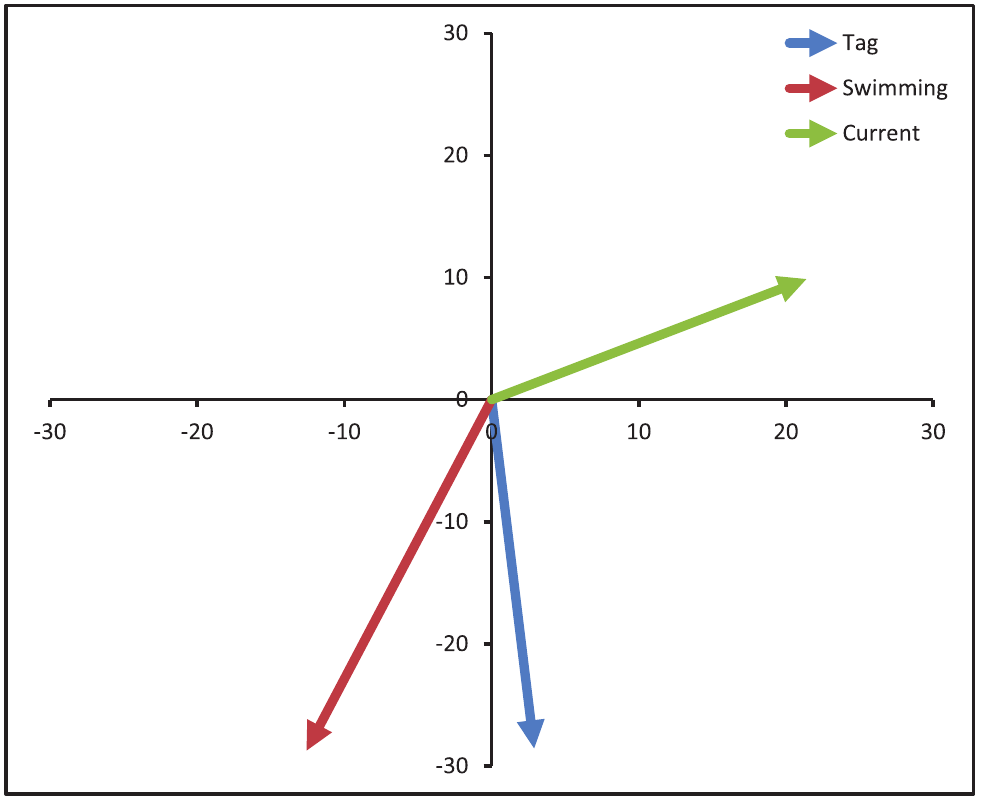
Figure 3. Average direction of tag movement, HYCOM shallow currents, and estimated swimming direction over the duration of this study. Axis units are in centimeters per second.